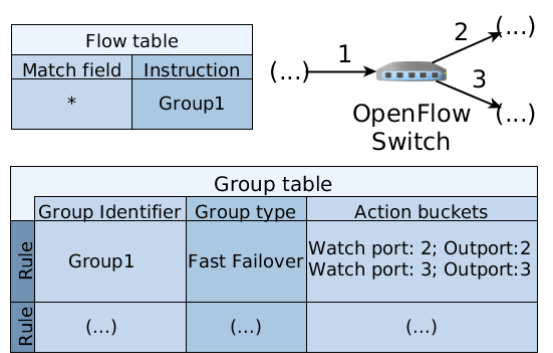
Figure 2. Scheme of the fast